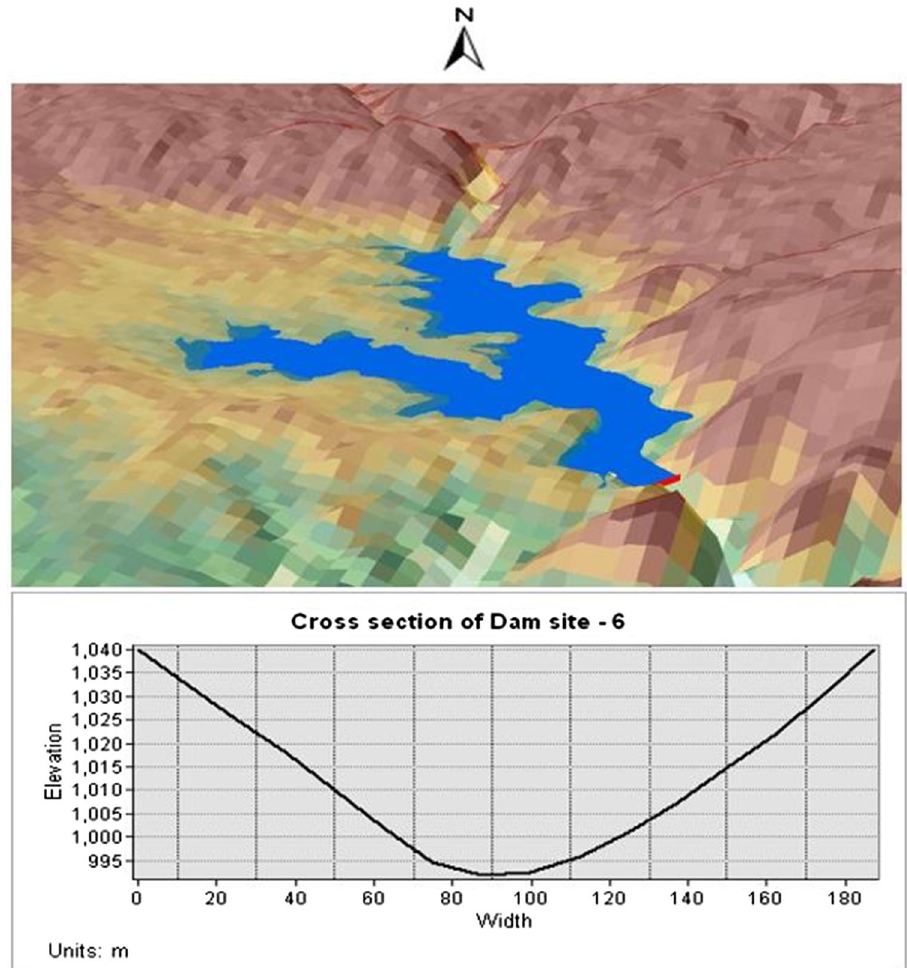
Fig. 23 3D view and cross sec- tion of proposed dam